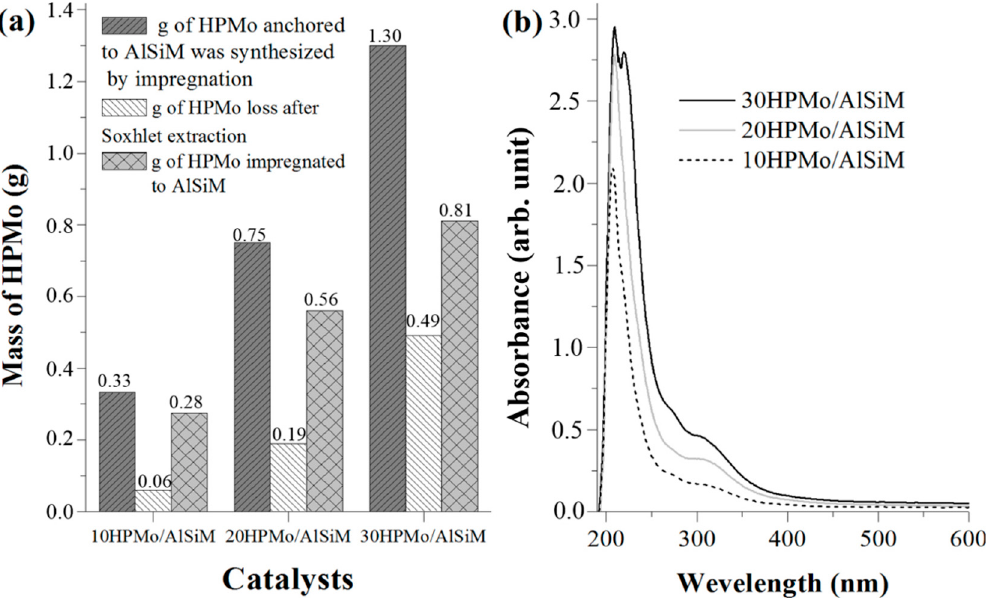
Figure 1. Quantification of HPMo losses by ultraviolet-visible (UV-vis) spectroscopy and calculation of immobilized HPMo ( a ); UV-vis spectra of the HPMo leached after the ethanolic washing of the supported materials ( b ); in all cases 3 g of AlSiM were used during the anchoring of